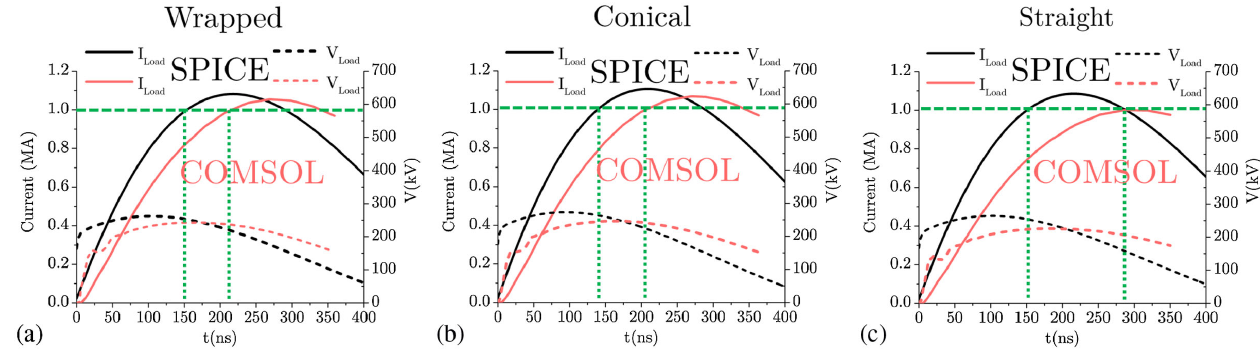
FIG. 8. Comparison between circuit and electromagnetic simulations for (a) wrapped, (b) conical, and (c) straight transmission